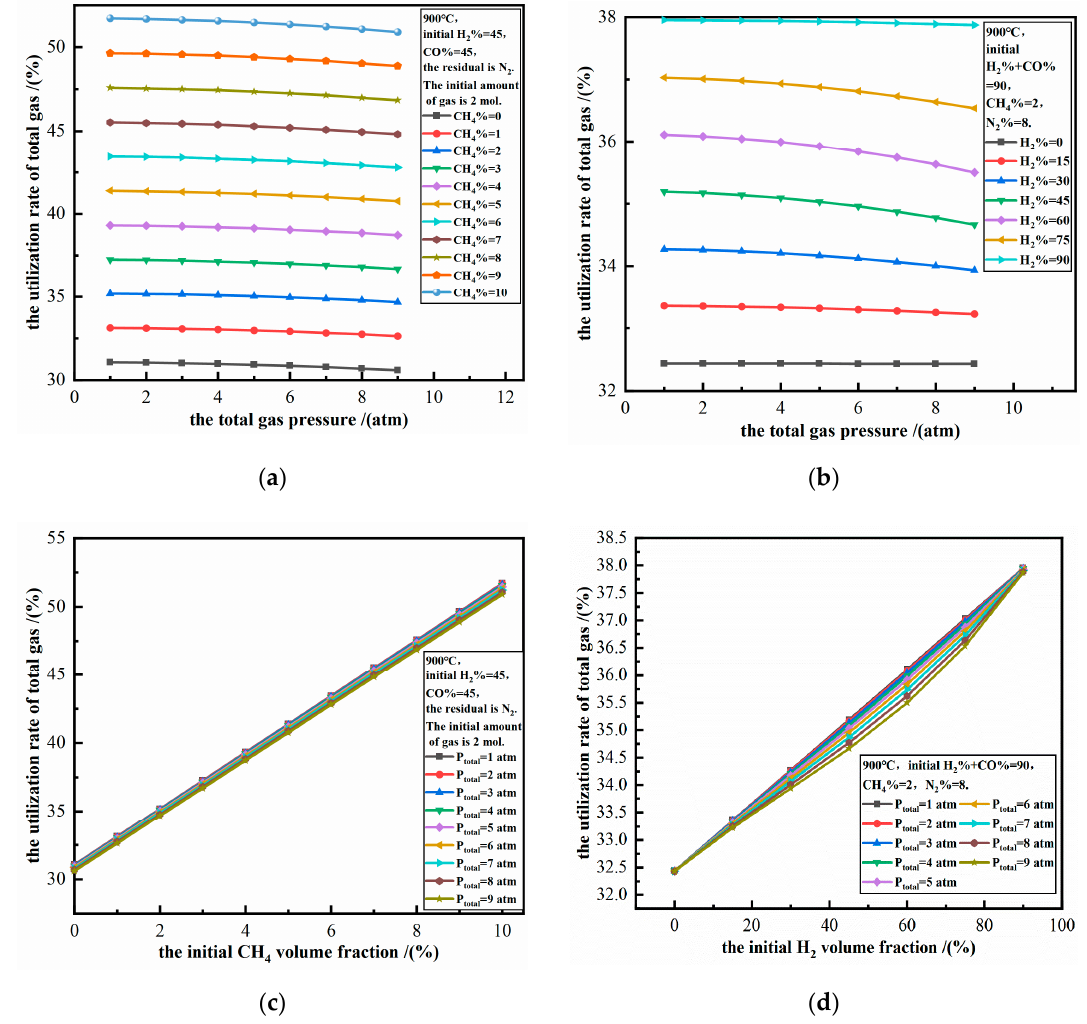
Figure 3. The relationship between the utilization rate of total gas and other initial conditions at 900 °C. ( a ) the x -axis is the total gas pressure, and initial H 2 % = 45, CO% = 45, CH 4 % = 0–10; ( b ) x -axis is the total gas pressure, and initial H 2 % + CO% = 90, CH 4 % = 2; ( c ) x -axis is the initial CH 4 volume fraction, and initial H 2 % = 45, CO% = 45; ( d ) x -axis is the total gas pressure, and initial H 2 % + CO% = 90, CH 4 % = 2.